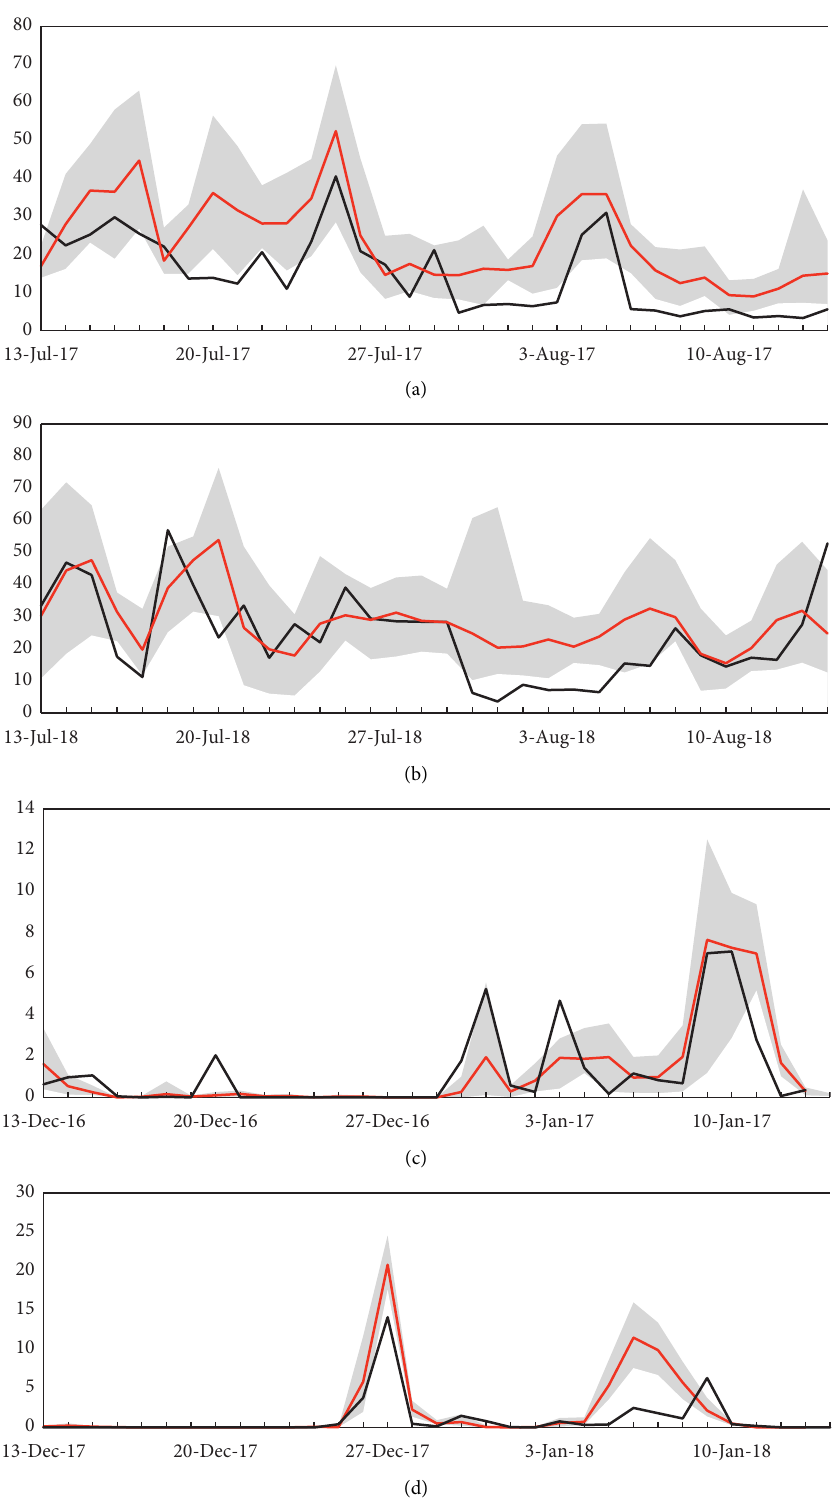
Figure 5: Time series plots of rainfall in mm for ensemble range (grey), ensemble mean (red), and DMH observation (black). (a) Wet season 2017, (b) wet season 2018, (c) dry season 2017, and (d) dry season